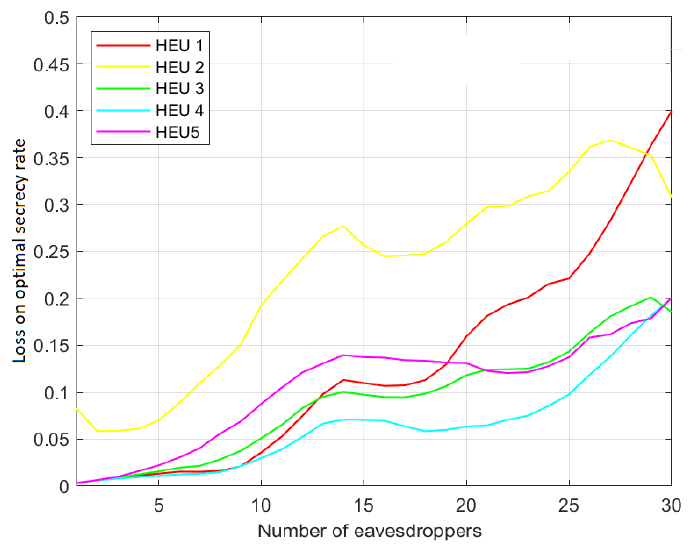
Figure 5. Percentage loss over optimum secrecy rate. Scenario (nc) with non-cooperative